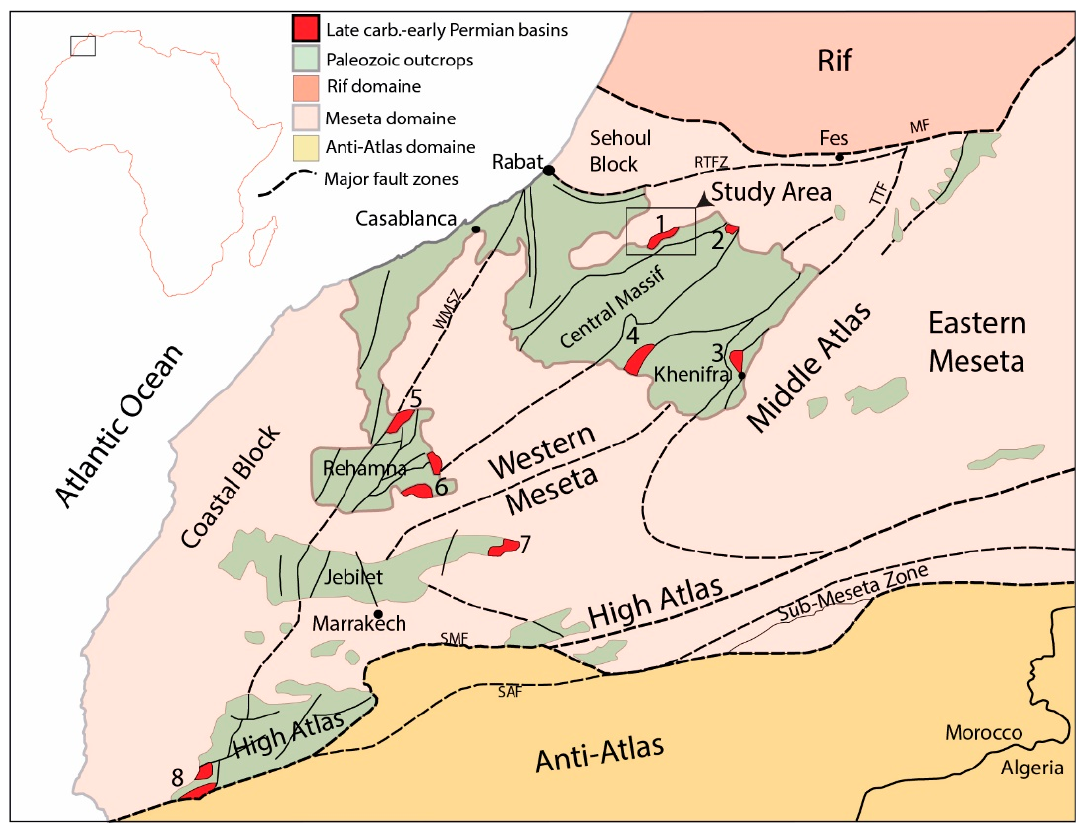
Figure 1. Principal tectonic domains of central Morocco (modified after [23–26]). Numbers 1–8 correspond to Carboniferous– Early Permian basins (1: the studied outcrops of Tiddas; 2: Bou Achouch, 3: Khenifra, 4: Chougrane, 5: Mechra ben Abbou, 6: Nzalet el Hararcha, 7: Senhaja, 8: Souss). Abbreviations: MF, Maghrebide Front; RTFZ, Rabat Tiflet Fault Zone; SAF, South Atlas Fault; SMF, South Meseta Fault; TTF, Tizi n’ Tretten Fault Zone; WMSZ, Western Meseta Shear Zone.